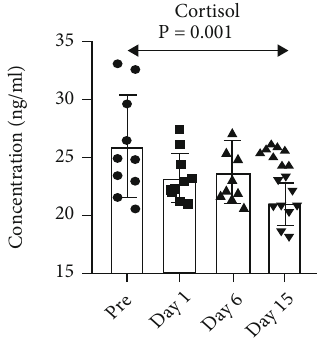
Figure 7: Cortisol measurement by ELISA. Cortisol concentrations in plasma were measured using an EIA kit (Salimetrics, Philadelphia, PA, USA) as described by the manufacturer. Resulting values were directly plotted for analysis.